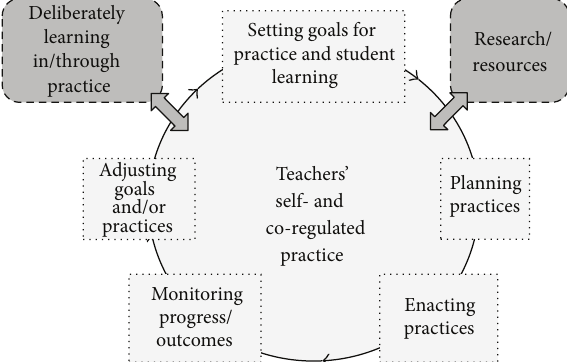
F 1: Teachers’ engagement in cycles of self- and co-regulated inquiry (see also